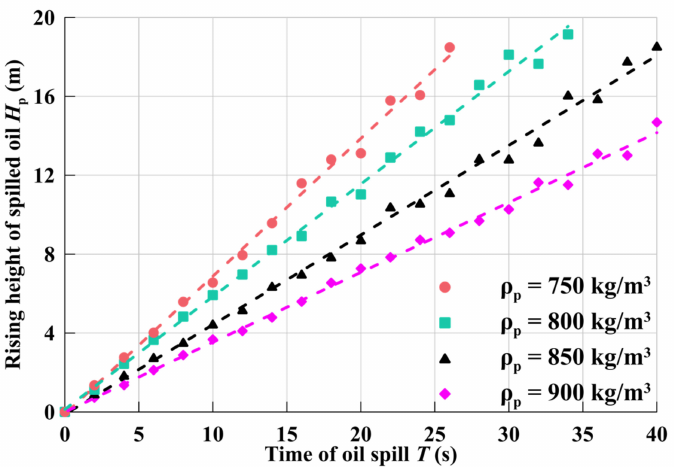
Figure 10. Rising height of spilled oil for three different oil densities. ( U P = 0.10 m/s). The lateral migration distance W p with time under different crude oil densities is in lateral migration distance in seawater. When ρ p = 750 kg/m 3 , the lateral migration distance of leaked oil in seawater after about 28 s is 14.7 m; when ρ p = 900 kg/m 3 , the lateral migration distance of spilled oil at T = 28 s is 8.5 m, which is 6.2 m different from the